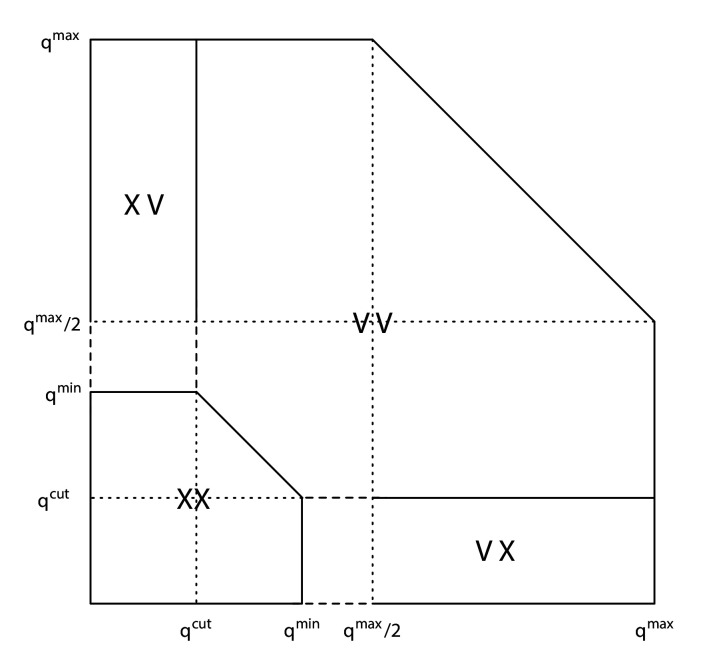
Regions of frequency space used to define observations and non-observations of allele frequencies.V indicates the identification of a variant, while X indicates the non-identification of a variant. Combinations of V and X indicate observations made in two replicate samples.